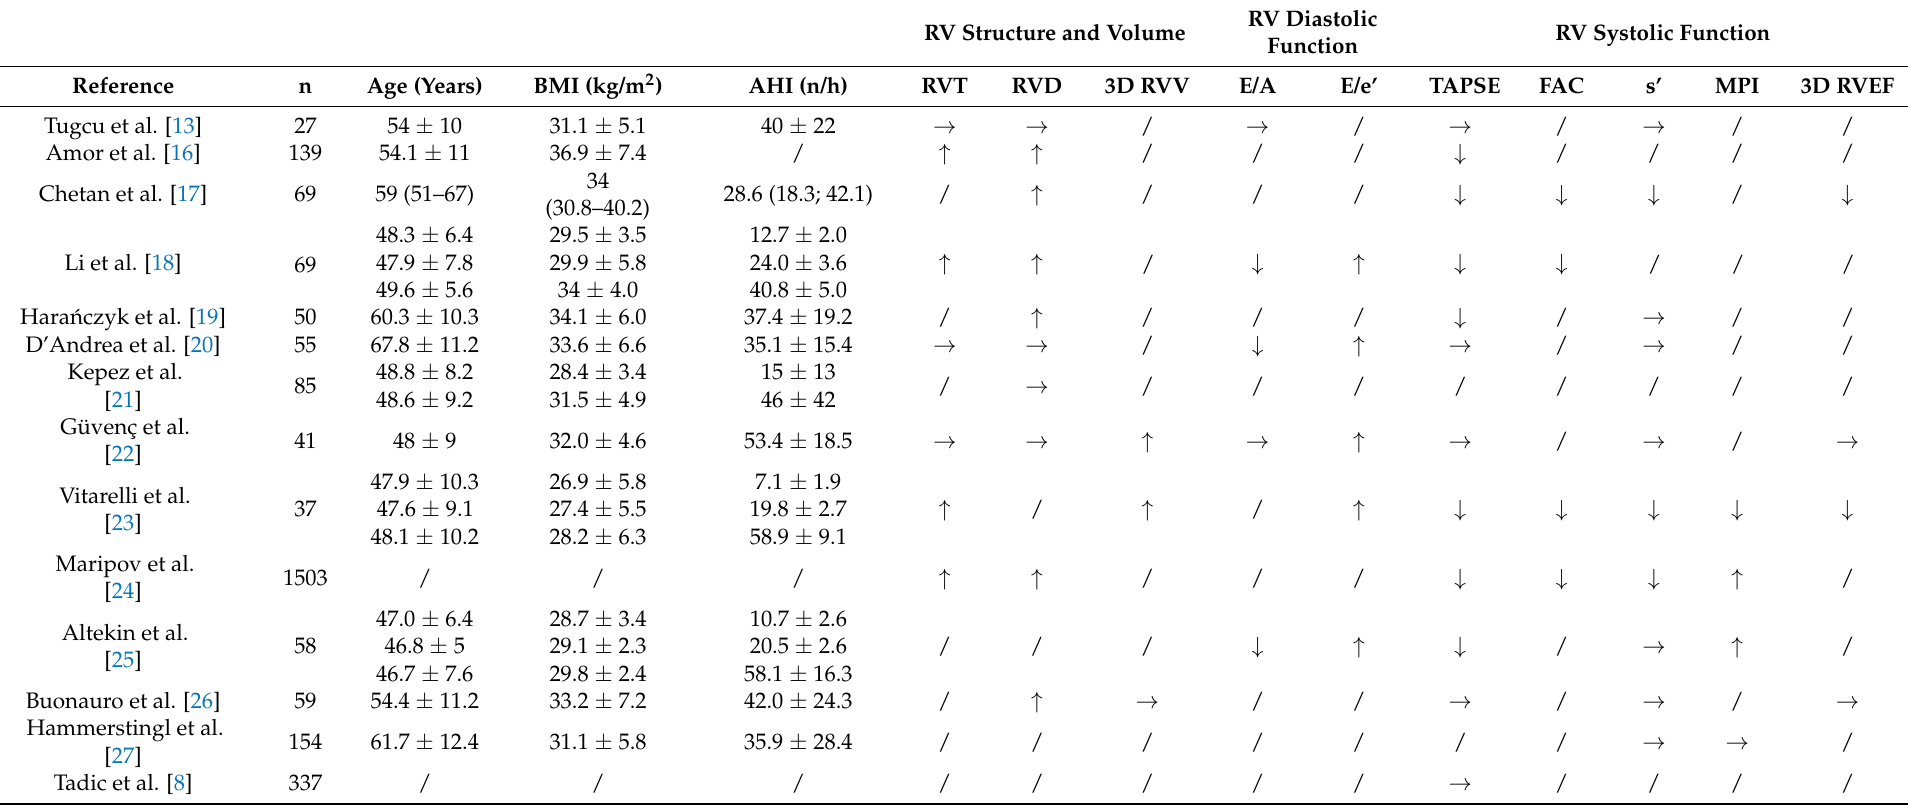
Table 1. RV structure, diastolic, and systolic function in OSA